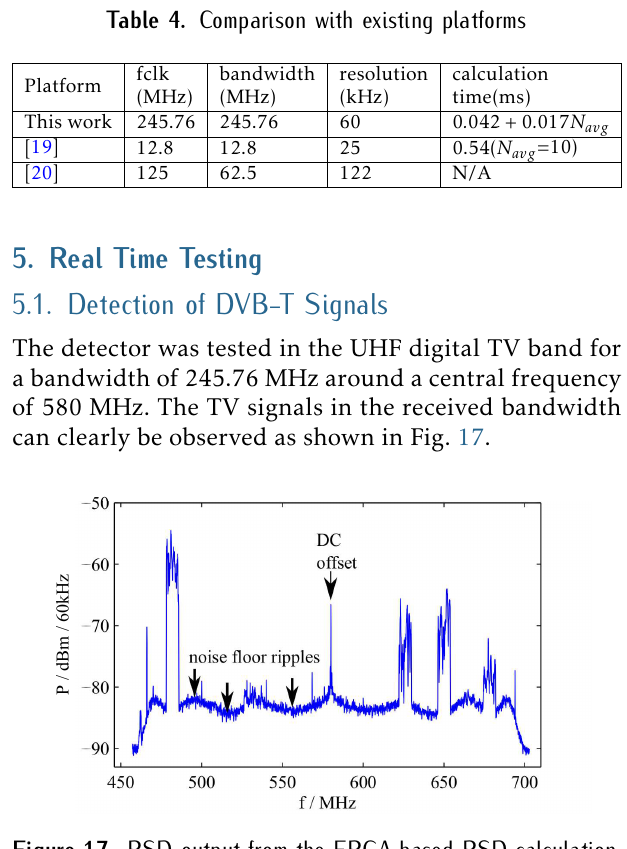
Figure 17. PSD output from the FPGA based PSD calculation. A ripple in the noise floor is observed. The calculation is performed using 100 averages.